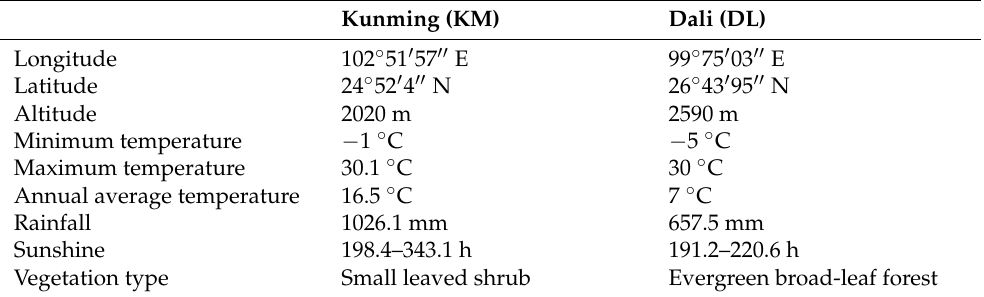
Table 1. Altitude, coordinates, temperature, sunshine, precipitation, and vegetation types in Kunming and Dali